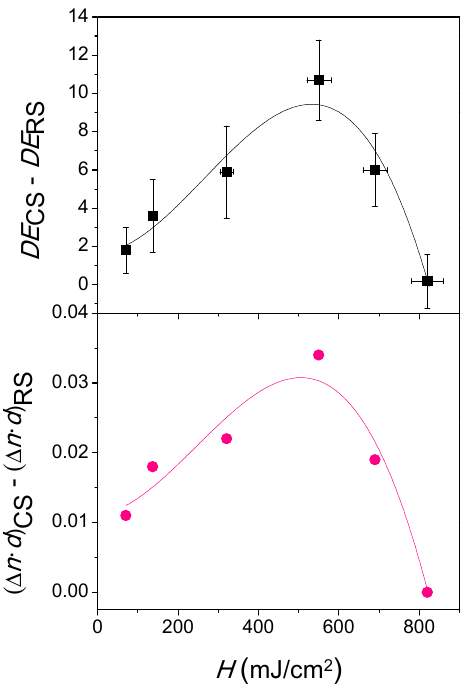
Figure 6. Differences between both curing and recording stage for diffraction efficiencies ( DE ) and ∆ n · d as function as radiant exposure ( H ). The lines represent the experimental data polynomial fit.